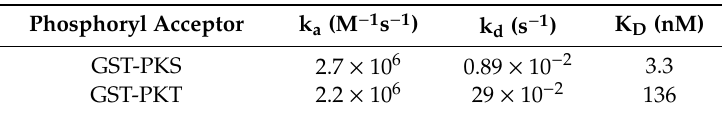
Table 3. Kinetic data for the formation of the Michaelis complex with PKA C α wt in the presence of 0.2 mM AMP-PNP and 1 mM MgCl 2 . Data derived from SPR analyses (Figure S5) of the interaction between PKA C α and GST-PKS or GST-PKT, respectively.